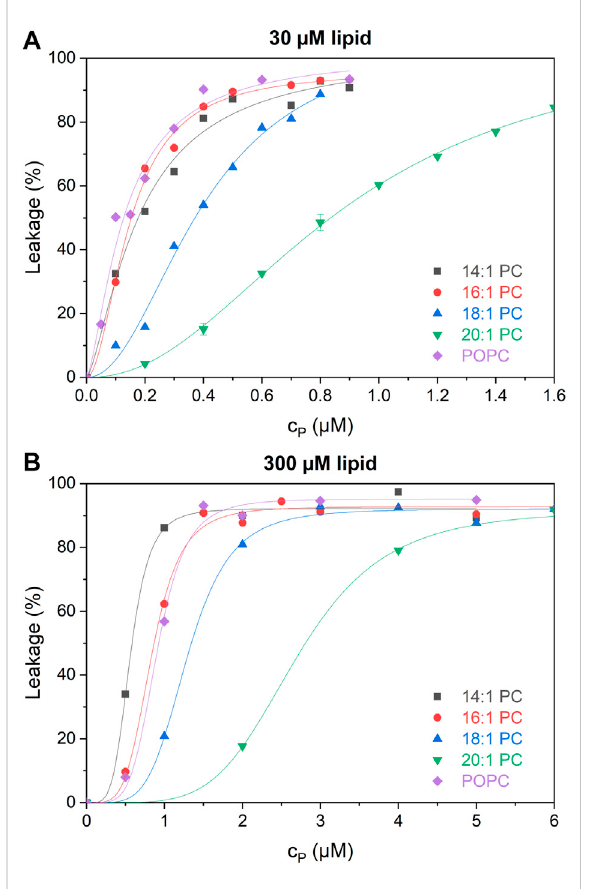
FIGURE 3 CalceinleakageLasafunctionoftotaltolaasinconcentration c P (µM) after 1-h incubation time in 30 µM (A) and 300 µM (B) of the tested lipids (see color code in the fi gure). Lines to guide the eye are fi tted by the Hill equation.